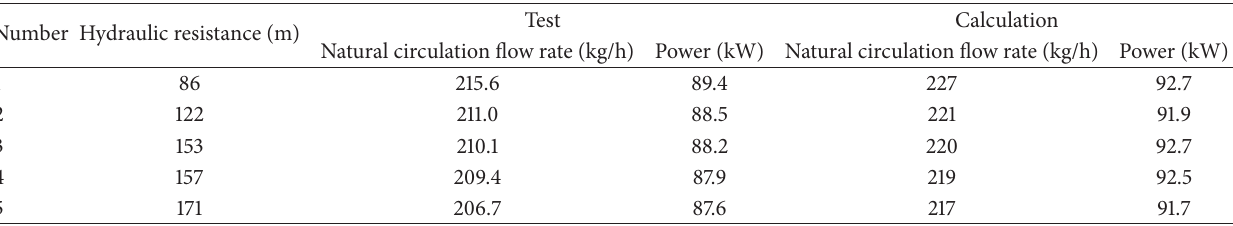
Table 2: Effect of the hydraulic